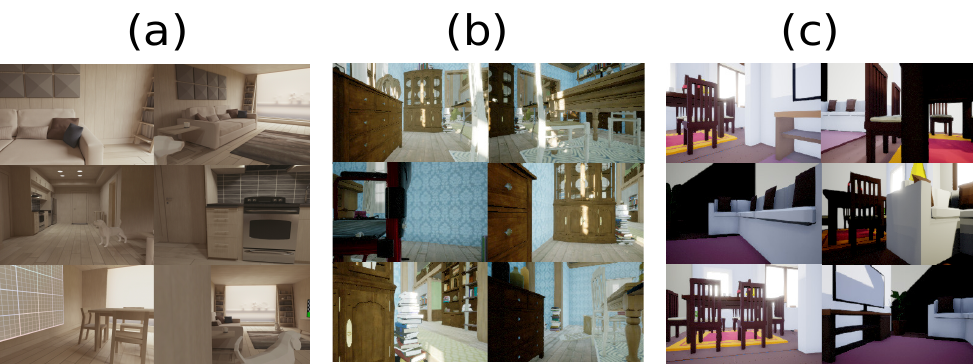
Figure 4. Unknown environments with different features, such as illumination, texture, and color. However, the environments involve furniture as a principal element. ( a ) It is an Android environment emulator, and the unreal store downloaded ( b , c ). Table 1. Description of each domain employing average and dominate color. Average Color Dominate Color Mean STD Mean